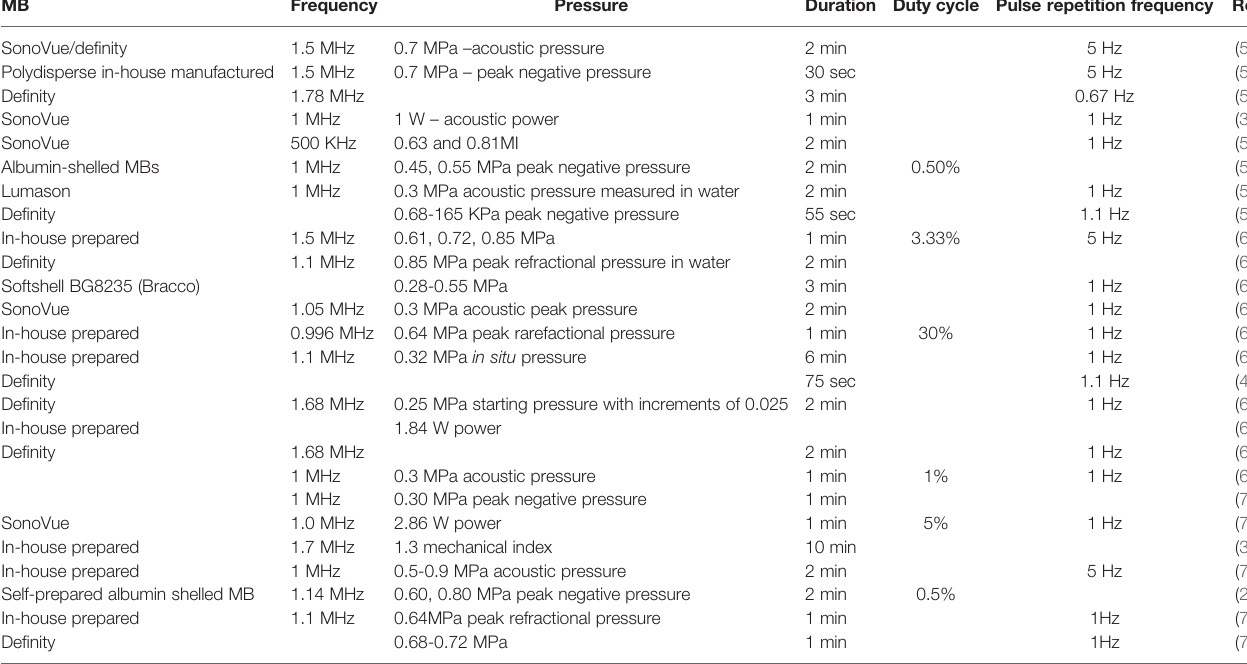
TABLE 3 | Parameters and MBs used in different preclinical studies.